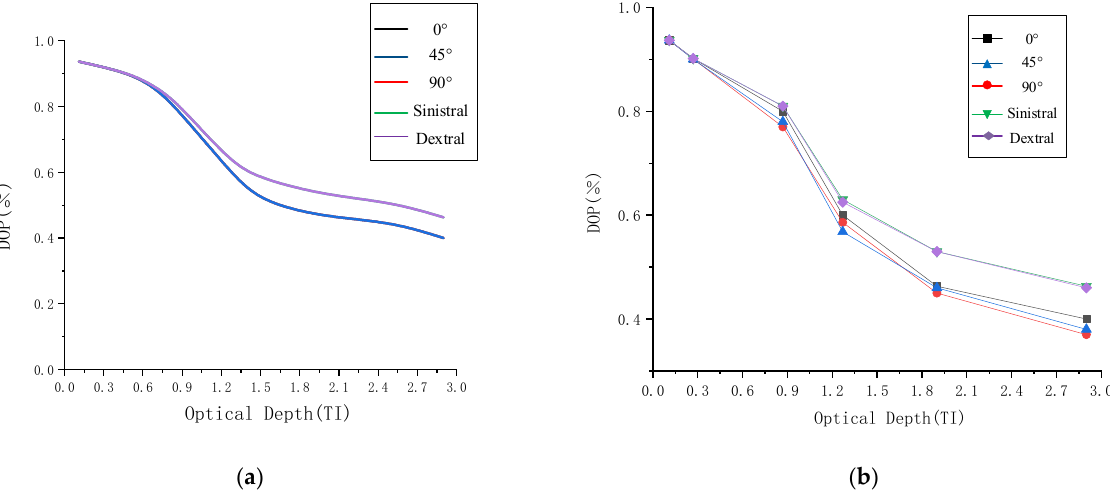
Figure 10. λ = Simulation and experimental comparison of DOP change of 671 nm polarized light: ( a ) simulation results and ( b ) experimental results.